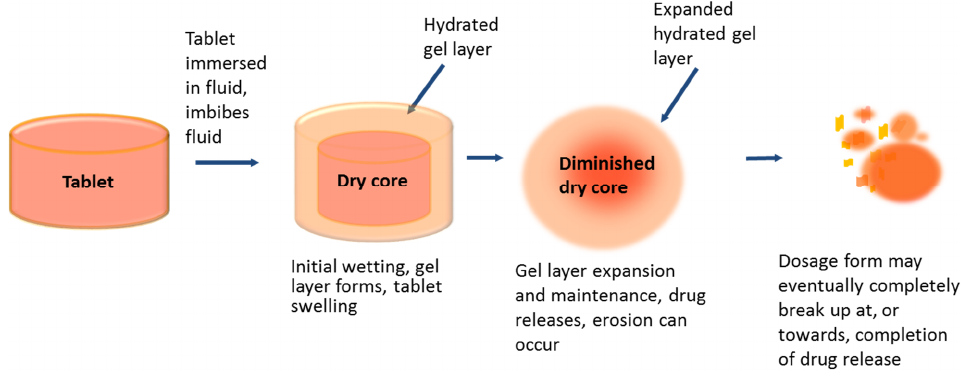
Figure 2. Progressive hydration of a hydrophilic matrix tablet through the process of drug release.